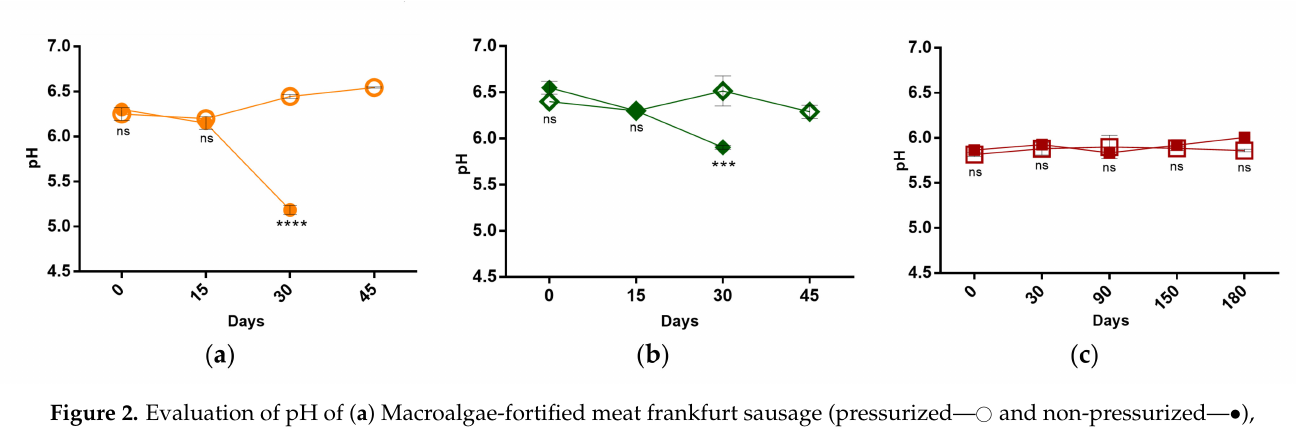
(cid:35) and non-pressurized— ), ( c ) Macroalgae-fortified